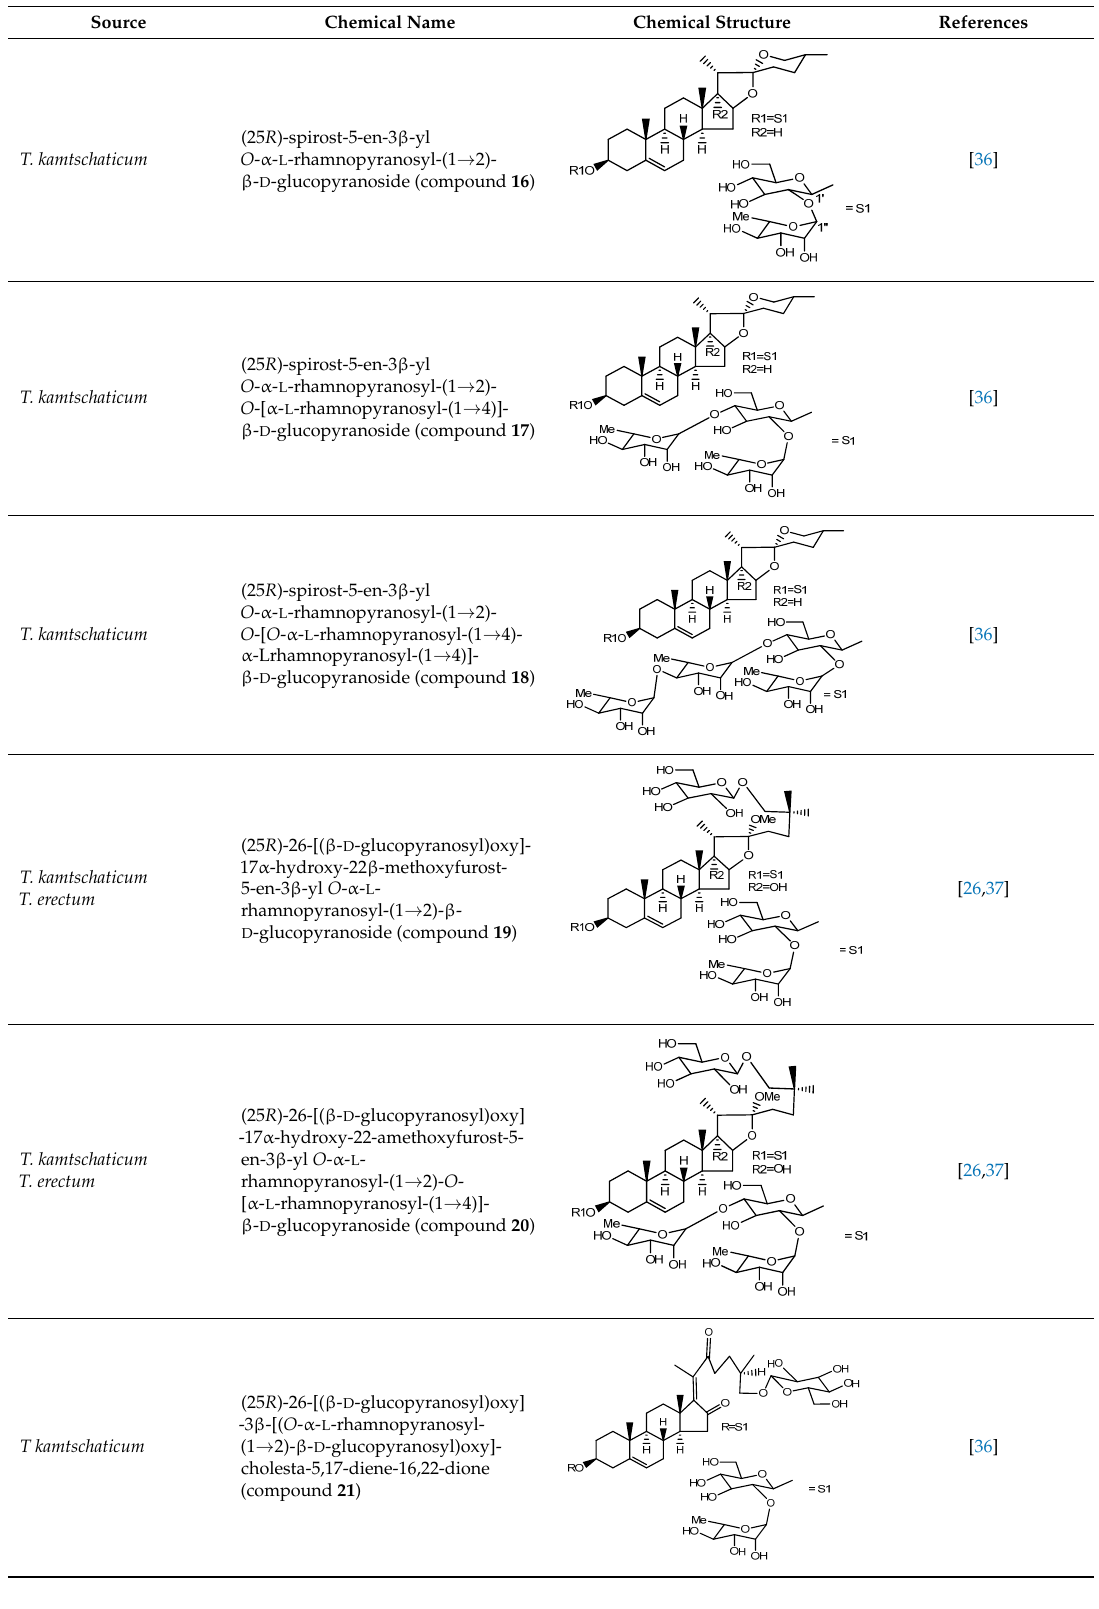
T. kamtschaticum Penogenin 3 ‐ O ‐α‐ L ‐ rhamnopyranosyl ‐ (1 → 2) ‐ O ‐β‐ D ‐ gl ucopyranoside (compound 23 )